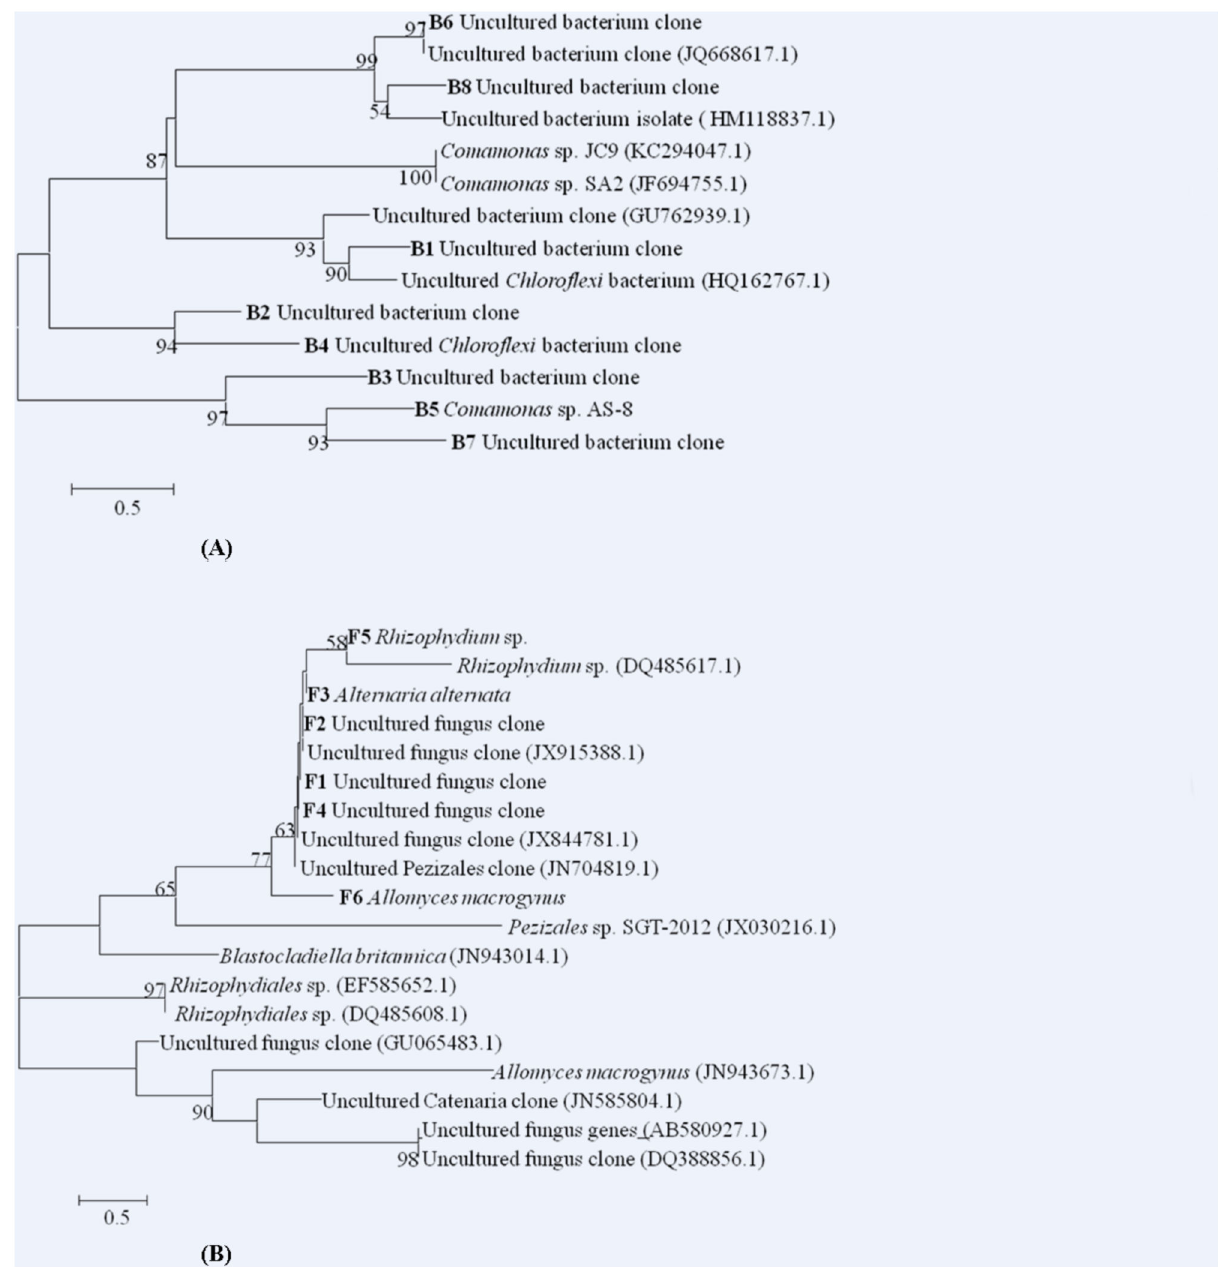
Figure 6. Phylogenetic affiliation of sequences retrieved from sediment (A) bacterial community and (B) fungal community. Bootstrap values (>50%) are indicated at nodes (1000 replications). Sequences obtained in the present study were shown in boldface. The internal letter and number (e.g. B1, F1) represents sequences in the DGGE fingerprints band B1 and F1. Scale bar represents 0.5 substitutions per nucleotide